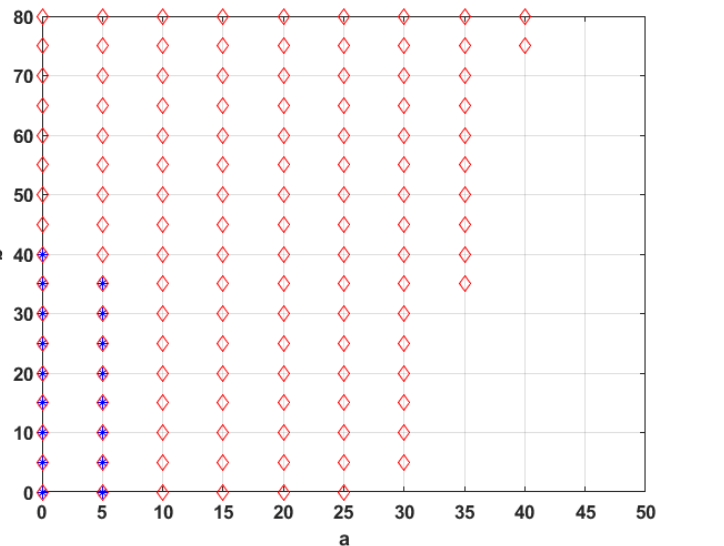
Figure 1. Comparison of the feasibility fields on parameter space a × b obtained via Theorems 2 “ ∗ ” and 3 “ (cid:5)